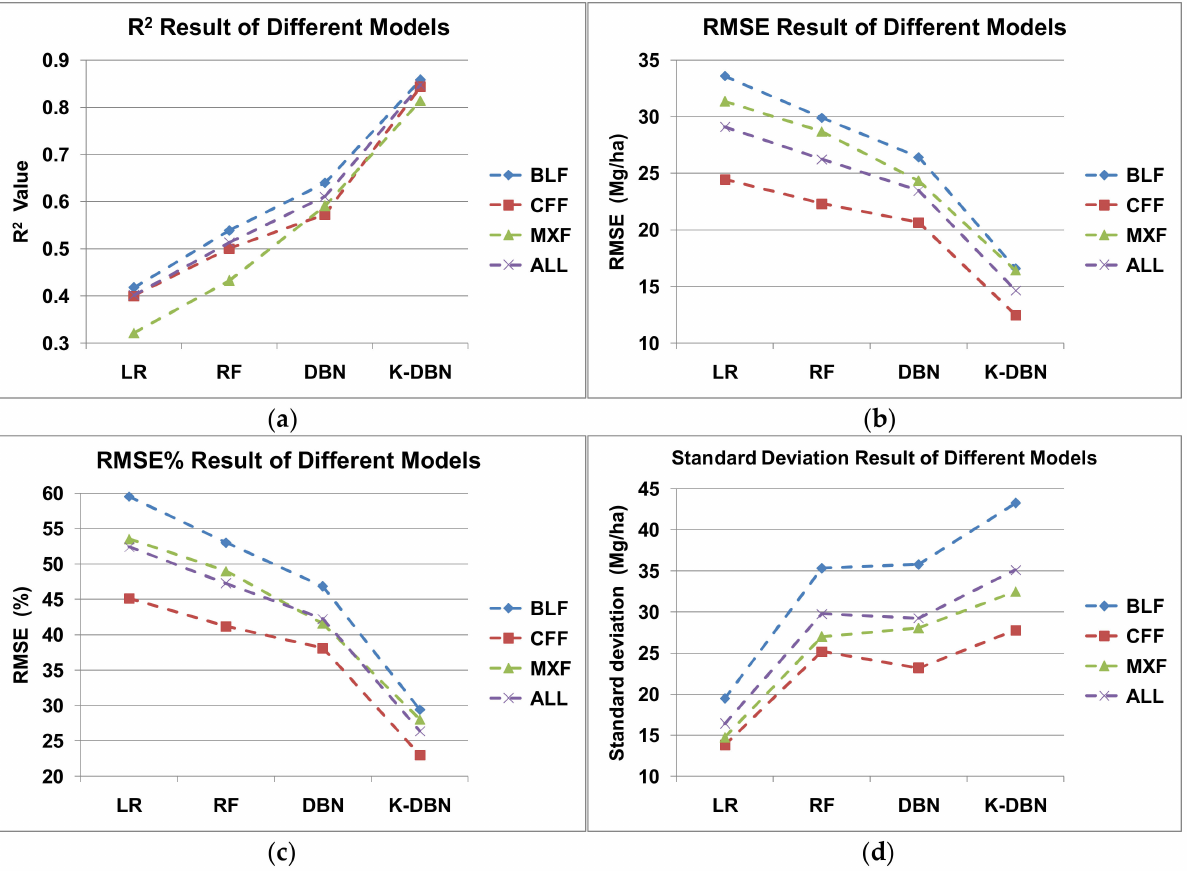
Figure 11. The performance comparison of various models (( a ): R 2 , ( b ): RMSE, ( c ): RMSE%, ( d ): Standard deviation). It can be seen that, compared with LR, RF, and DBN, K-DBN can more accurately predict the AGB. In combination with Figure 9, the AGB distribution of the measured samples presented a small to large trend. Figure 12 showed the results of prediction